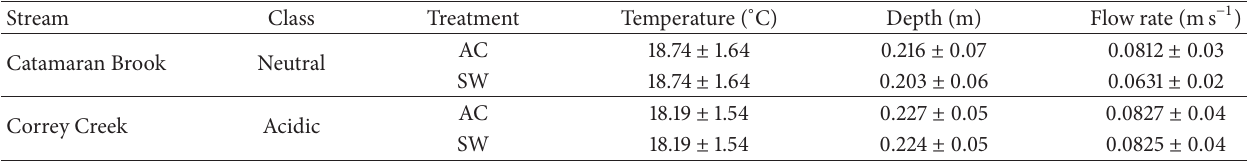
Table 2: Mean ( ± SD) values of physical characteristics captive 0 + Atlantic salmon ( Salmo salar ) were exposed to inside mesh enclosures during a cross-population transplant experiment 1 .